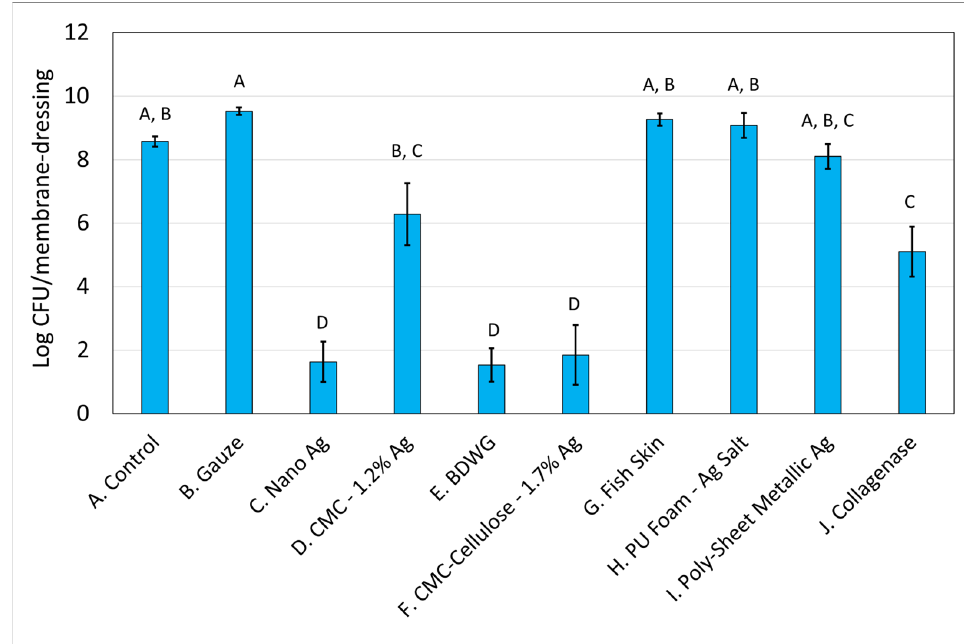
Figure 1. S. aureus Log CFU recovered from membranes inoculated with mixed bacterial species and either left untreated (A), treated with saline soaked gauze (B), or treated with wound care products (C through J). If treatments have the same letter listed above the column, they are not statistically different at p = 0.05. The error bars depict the standard error of mean.